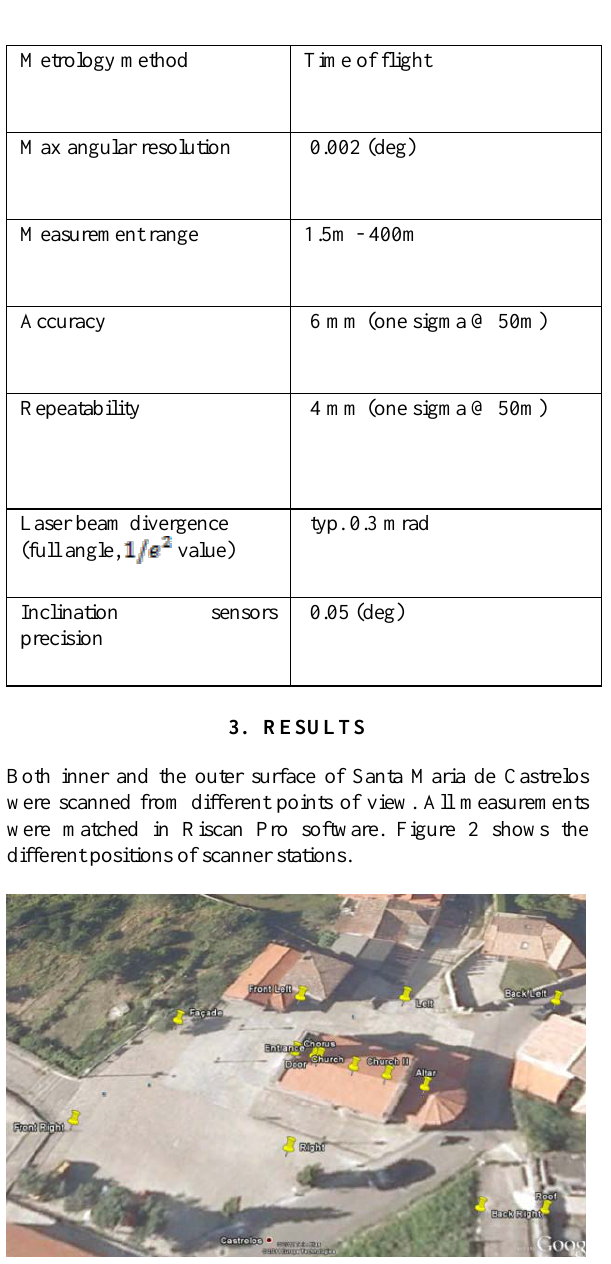
Table 1: Some technical especifications of Riegl LMS-390i are sumarized.